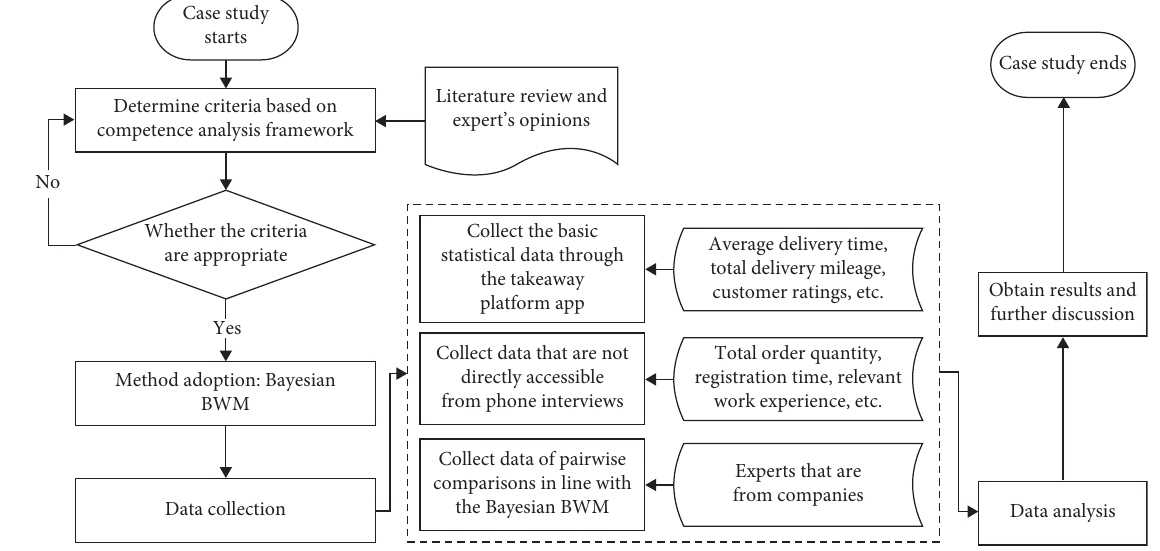
Figure 2: Case study